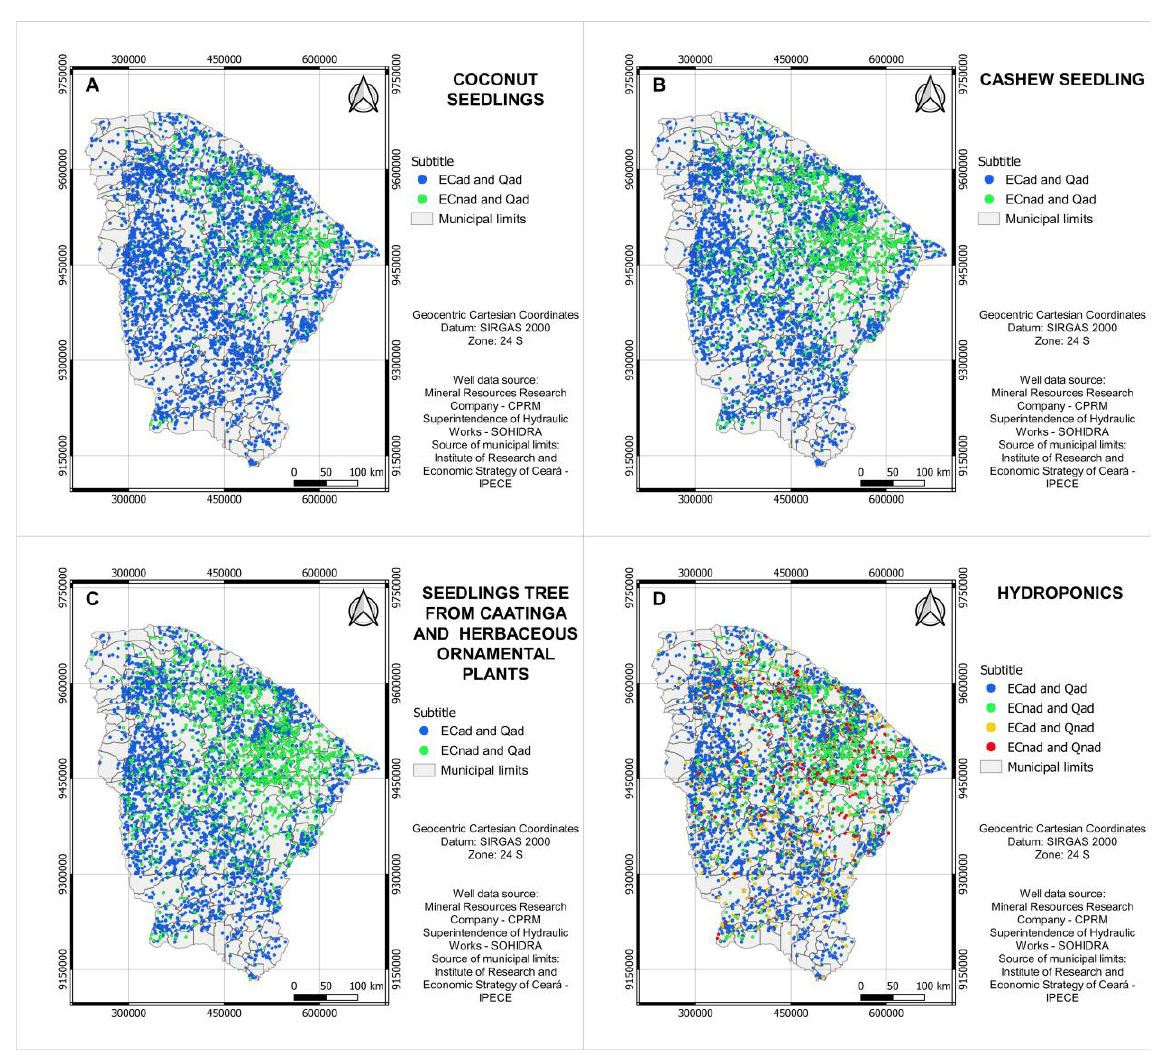
Figure 7. Potential of brackish groundwater in the State of Ceará (Northeast Brazil) to produce 2000 seedlings in nurseries of coconut ( A ), cashew ( B ), and trees native to the Caatinga biome/ornamental plants ( C ) ), and to produce vegetables in hydroponic cultivation of 100 m 2 ( D ), based on the threshold electrical conductivity of the irrigation water (EC) and discharge rate (Q). EC ad : adequate electrical conductivity; EC nad : inadequate electrical conductivity; Q ad : adequate discharge; Q nad : inadequate discharge.